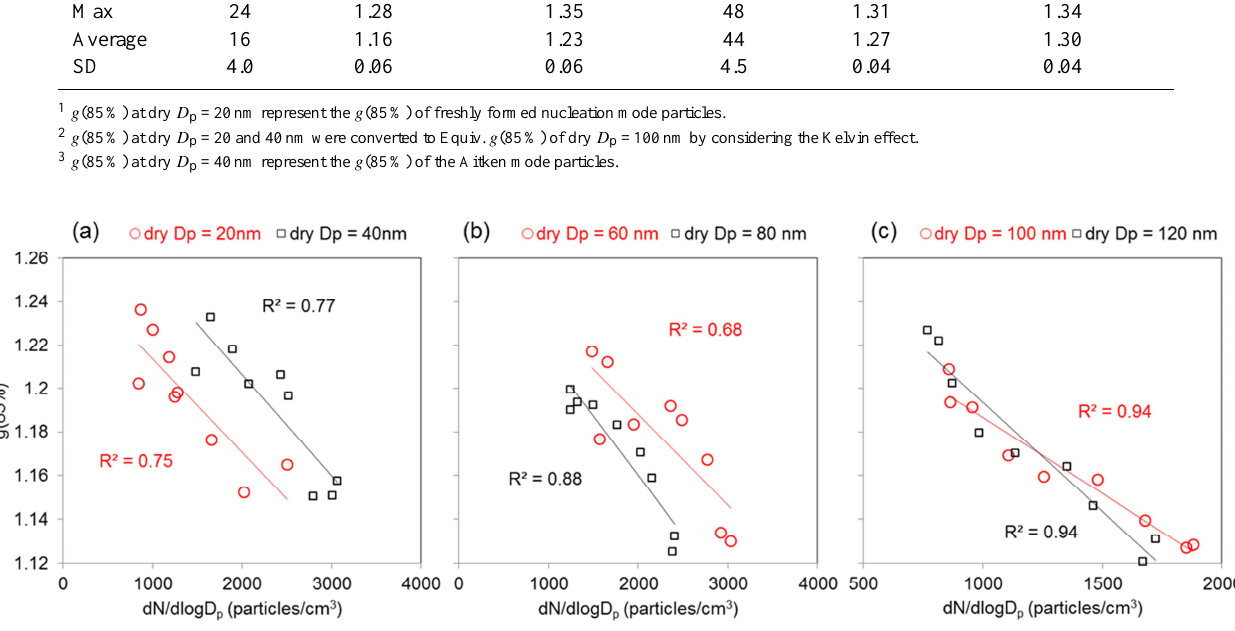
Figure 5. Scatter plots of g (85%) versus particle number concentrations in each size bin during the NPF events. (a) Dry D p =20 and 40nm. (b) Dry D p =60 and 80nm. (c) Dry D p =100 and 120nm. The data points are 30min averaged g (85%) values and particle number concentrations from 04:00 to 08:00LT are marked (A) in Fig. 4a and